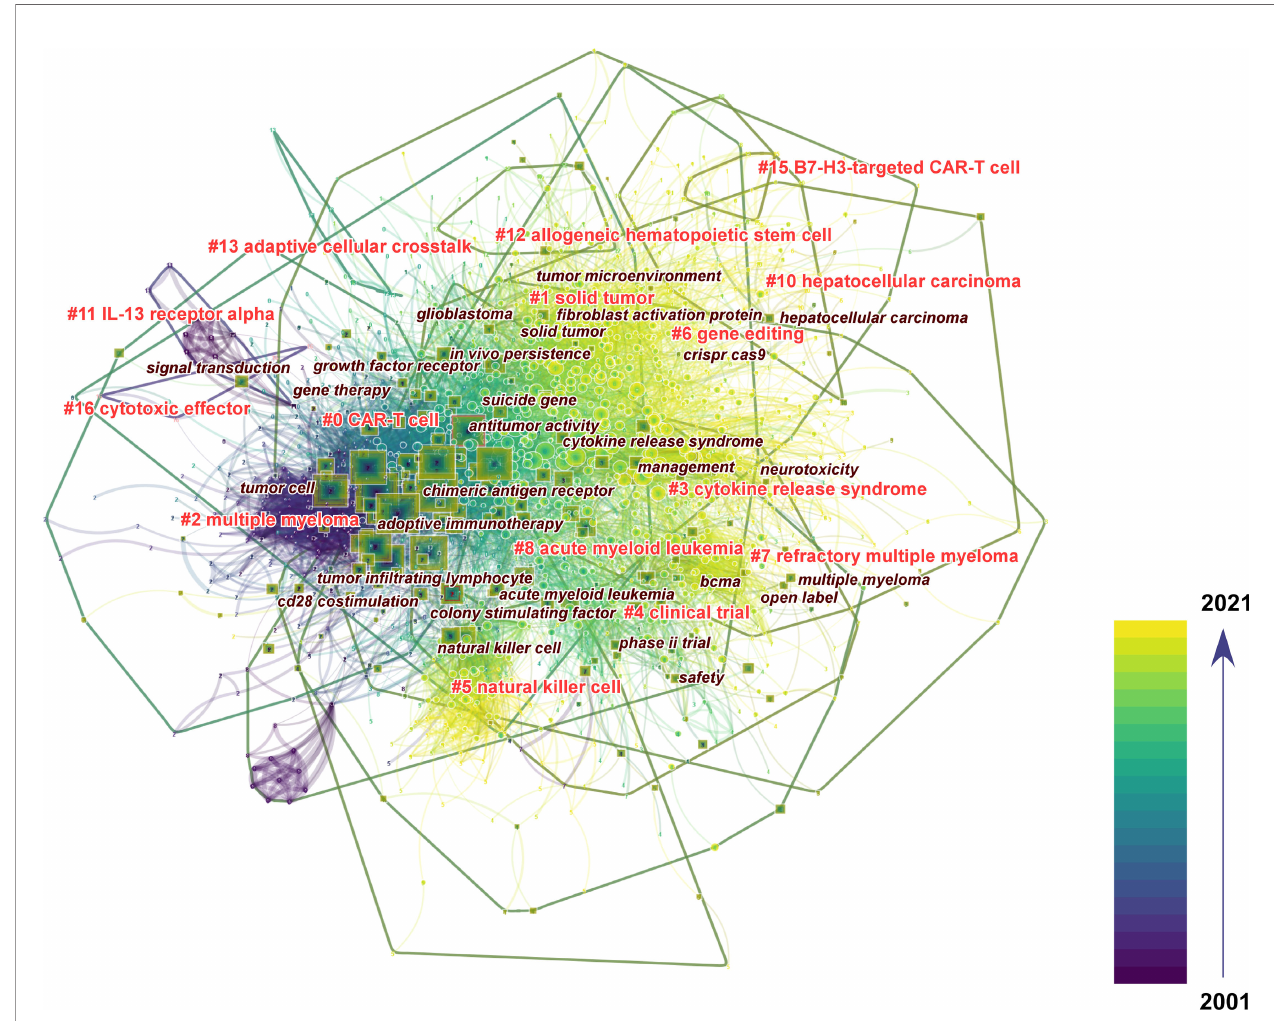
FIGURE 6 | The mixed visualization map of both co-cited references and keywords. Each node represents an article or review, each square represents a keyword, and each frame represents a cluster. The size of each node and square represent the numbers of co-citations and co-occurrences, respectively. The labels of the clusters and the most relevant keywords were also displayed adjacent to the frames. The color indicates the publication year of the articles.